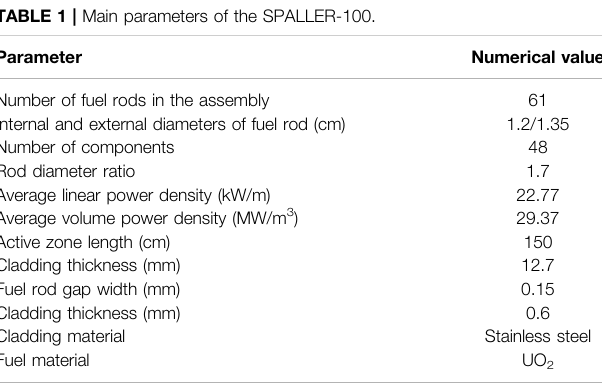
TABLE 1 | Main parameters of the